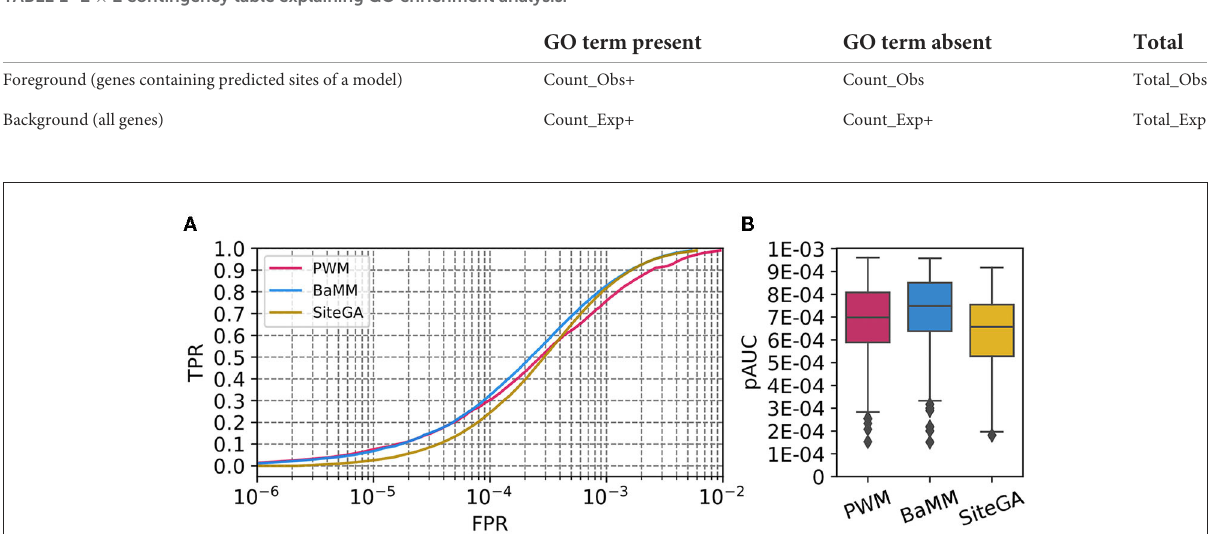
model yields a performance worse than those of